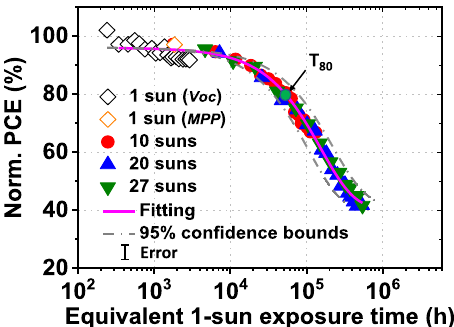
Fig. 6 Aging acceleration factor and extrapolated OPV